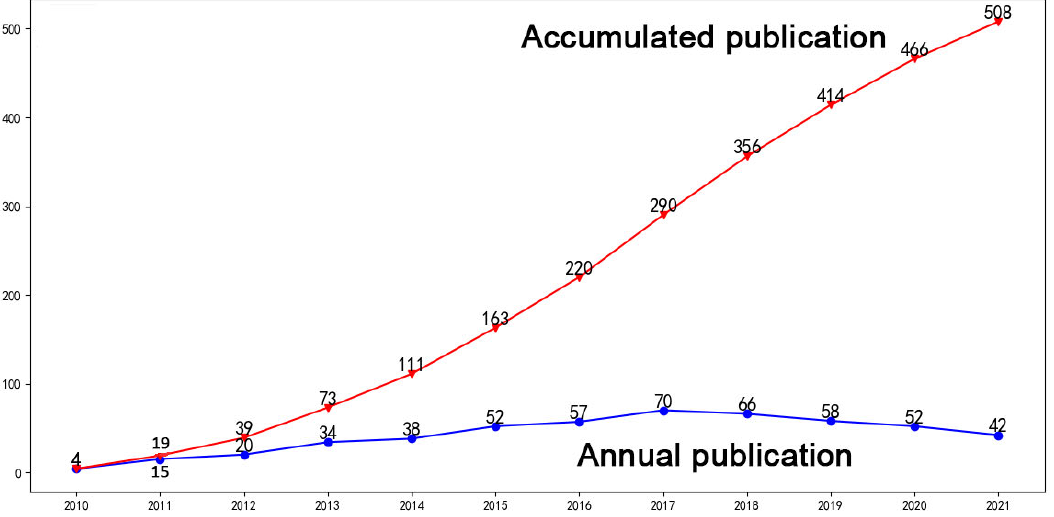
about graphene-based Figure 1. Annual and accumulated publications from 2000 to 2021 searched in the Web of Science about graphene ‐ based SERS.